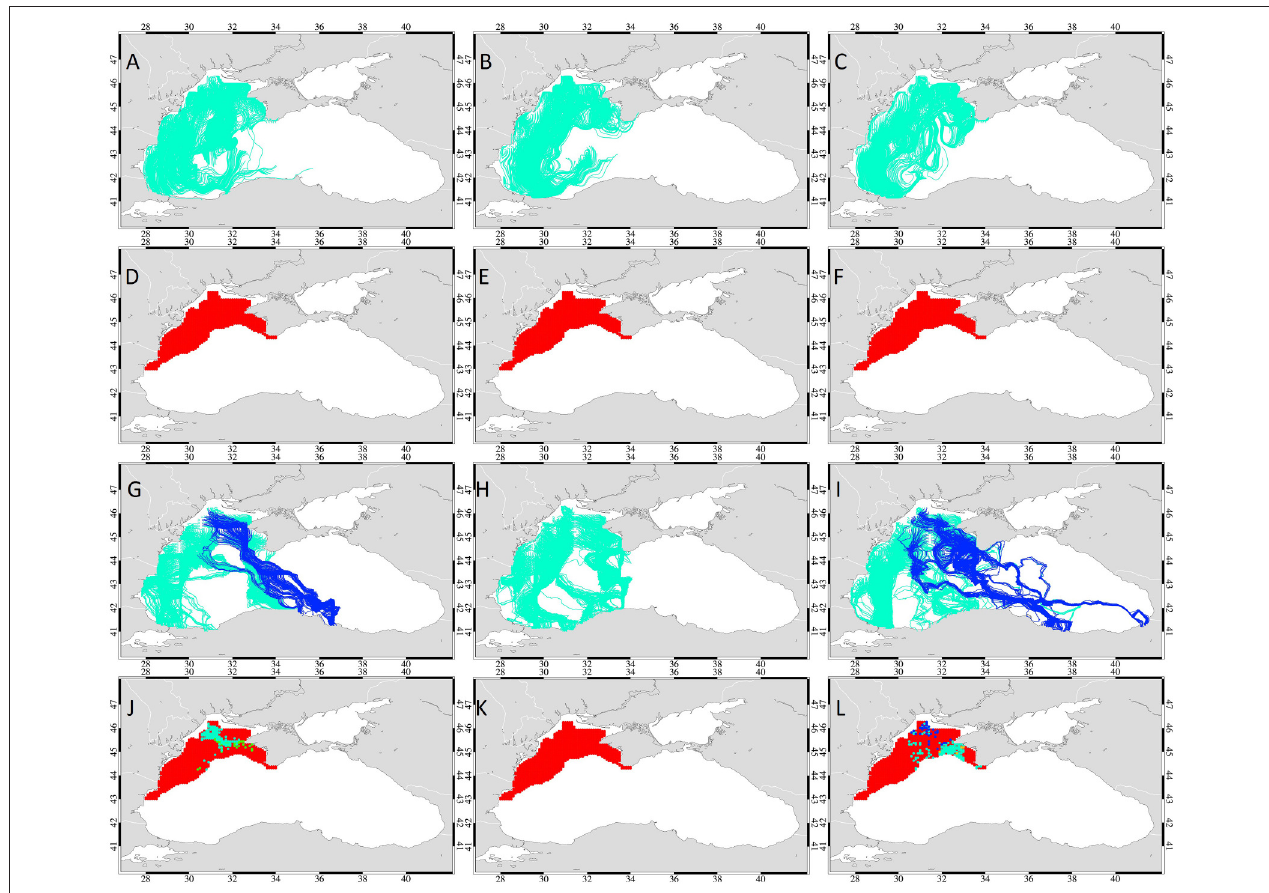
FIGURE 7 | Simulations of interannual variability: The paths (A–C,G–I) and start points (D–F,J–L) of drifters released on the northwestern shelf at the end of October. Drifters were advected by surface geostrophic currents alone (A–F) and followed temperature gradients (G–L) swimming 5 bl/s in 2001, 2002, and 2003 (left, middle, and right column). The paths of drifters reaching the overwintering area in 2 months are marked blue, the ones that do not reach are marked green. The start points of drifters that complete a successful migration in 2, 4, 6, and 8 weeks are color-coded green, cyan, yellow and dark blue, respectively. The start points of the drifters that fail to reach the overwintering grounds are marked